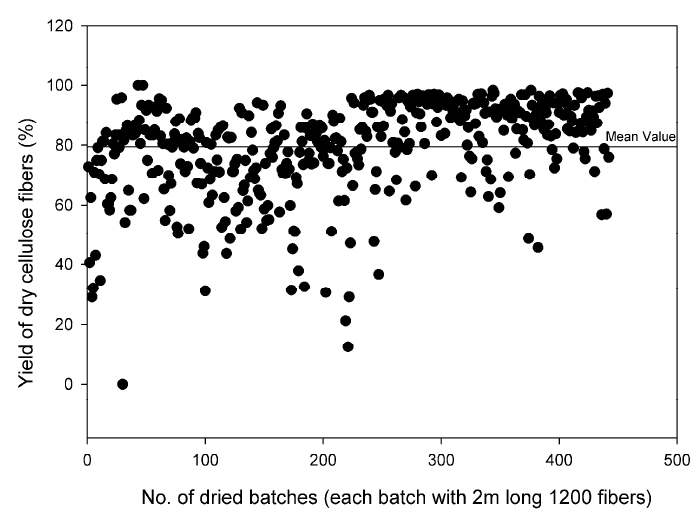
Figure 13. Yield (%) of 460 spinning-sessions of dried cellulose: RH (90 – 40%) and Temp (20 – 25 °C).